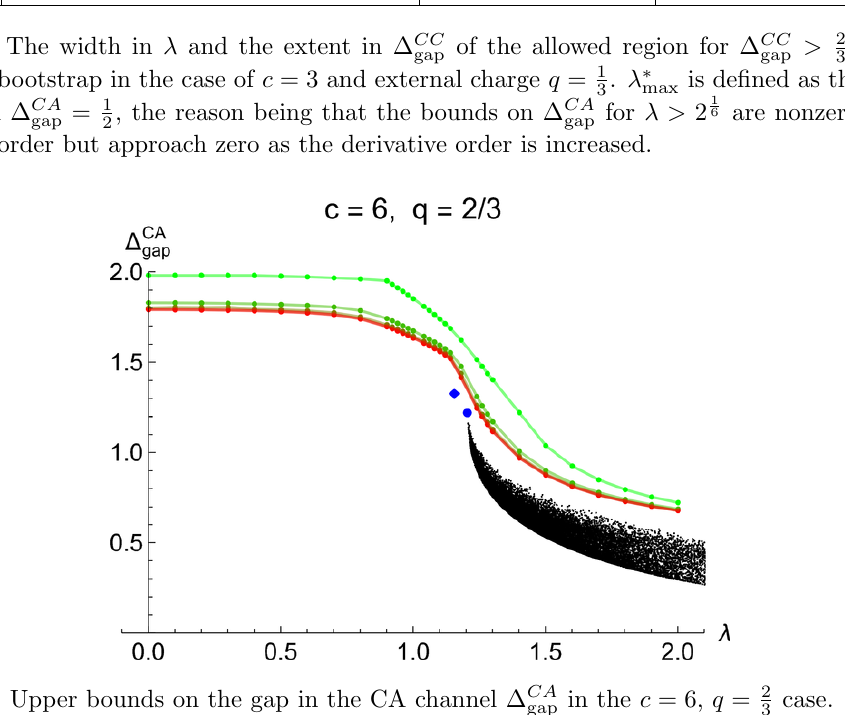
in the c = 6, q = 2 case. The green gap 3 ) for the T 4 = Z 3 CFT, in the absence of gap